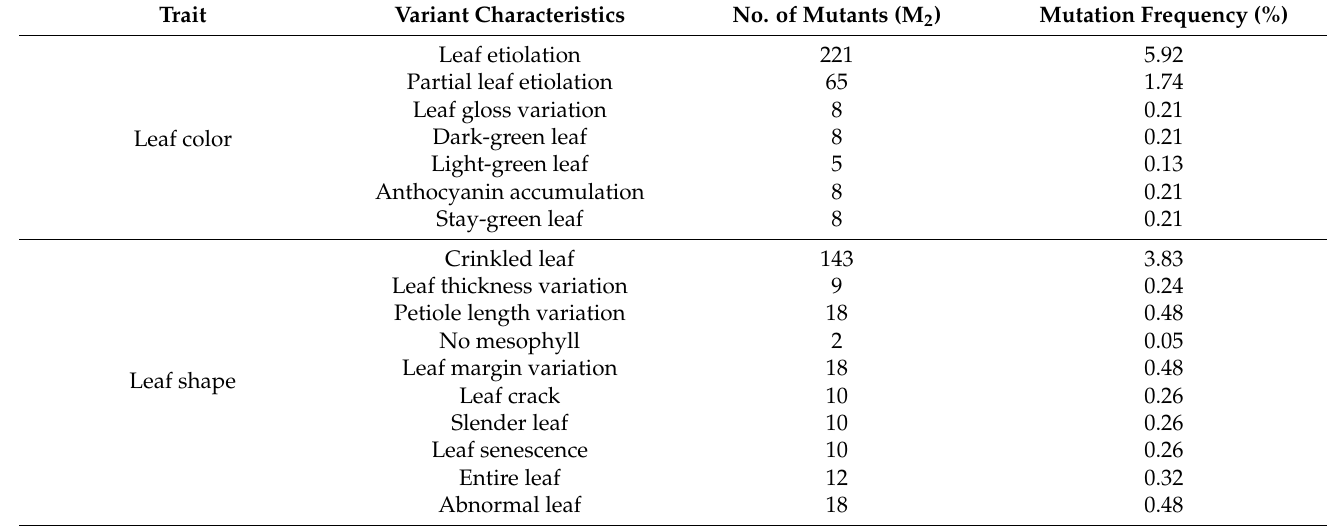
Table 4. Characterization of mutation types in the M 2 plants of Chinese cabbage (seed EMS